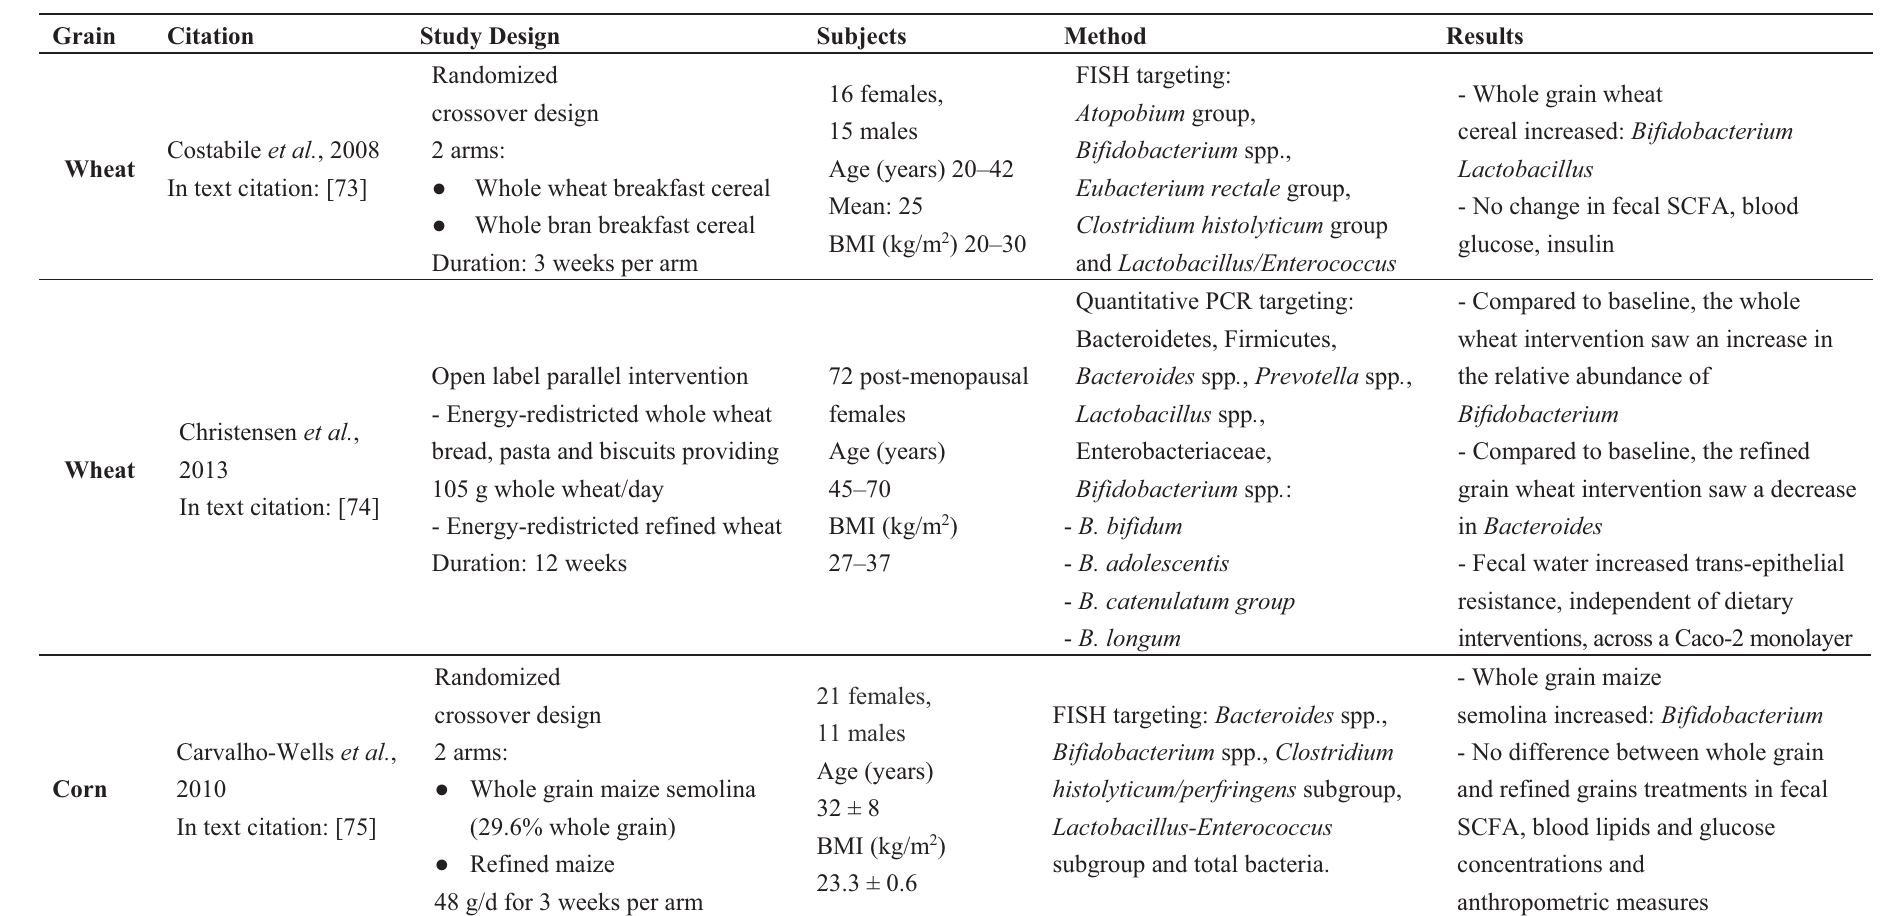
Table 1. Whole grain intervention trials examining